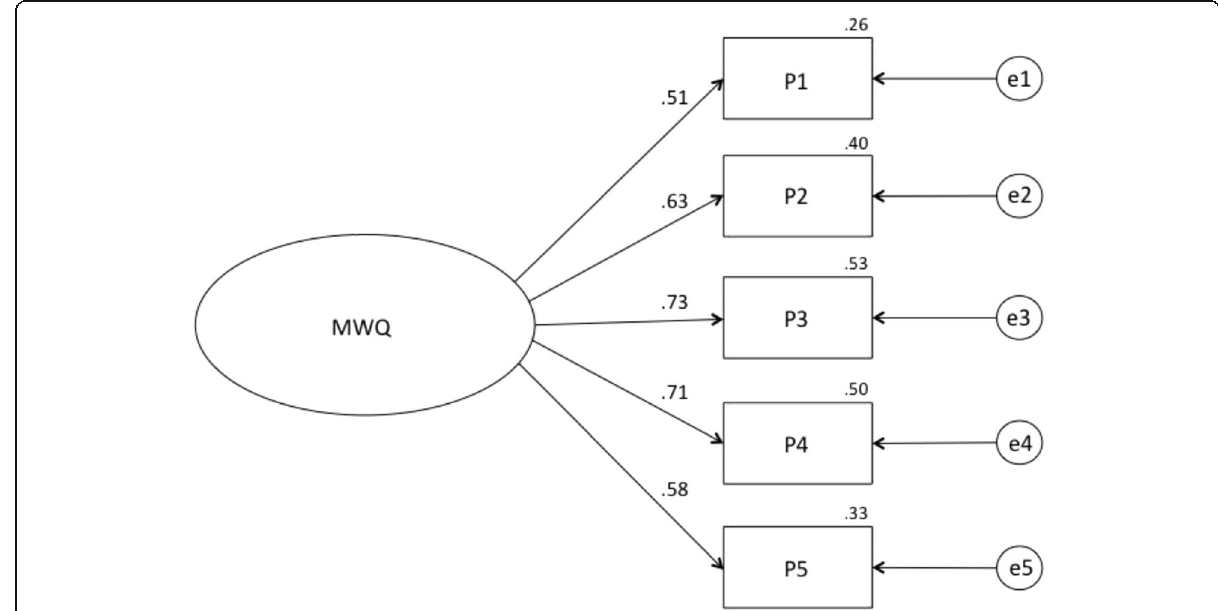
Fig. 2 Estimated normalized parameters of the CFA model